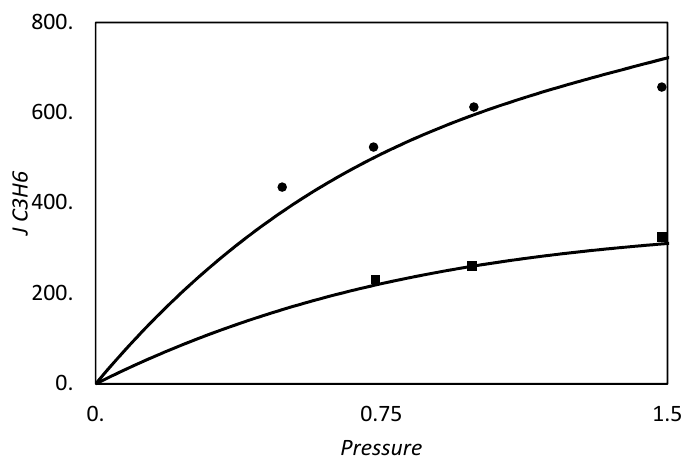
Figure 17. Ethylene flux as function of upstream pressure in membranes of poly-vinyldene fluoride (PVDF) containing AgBF 4 as fixed carrier at two different temperatures. Symbols are experimental data from Zarca et al., lines are model results. From the top, T = 303.15 and 293.15 K. Flux is expressed in (1 × 10 − 6 mol/cm 2 ·s), pressure is in (atm).